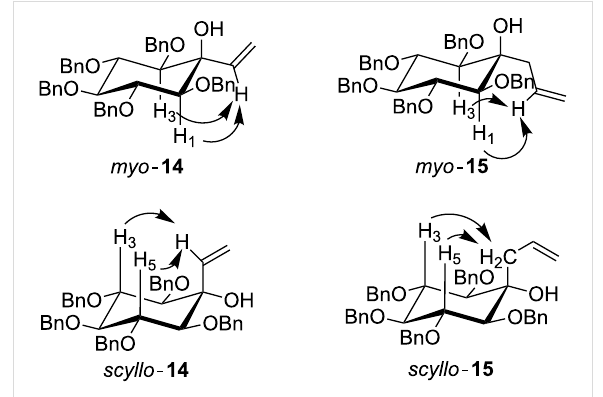
Figure 2: nOe correlations for C-alkenylated inositol